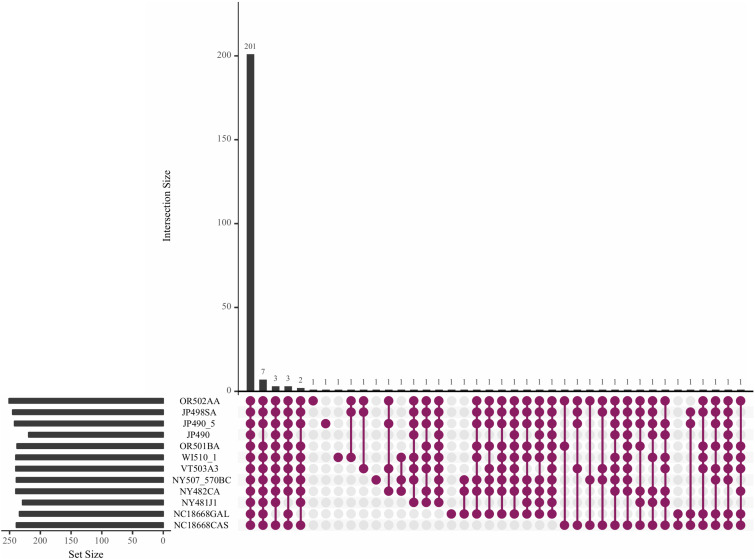
Upset plot showing the trend of effector transcripts in the sporangia of Pseudoperonospora humuli isolates. RNAseq reads from sequenced sporangia of different isolates were mapped to P. humuli gene calls (Rahman et al., 2019) using TopHat version 2.0.6 (Trapnell et al., 2009). Reads were counted using the HTSeq python module (Anders et al., 2014) and reads per kilobase million (RPKM) values were calculated. An RPKM > 0 was used to indicate the presence of a transcript. The plot was generated using the R package UpsetR (Conway et al., 2017).